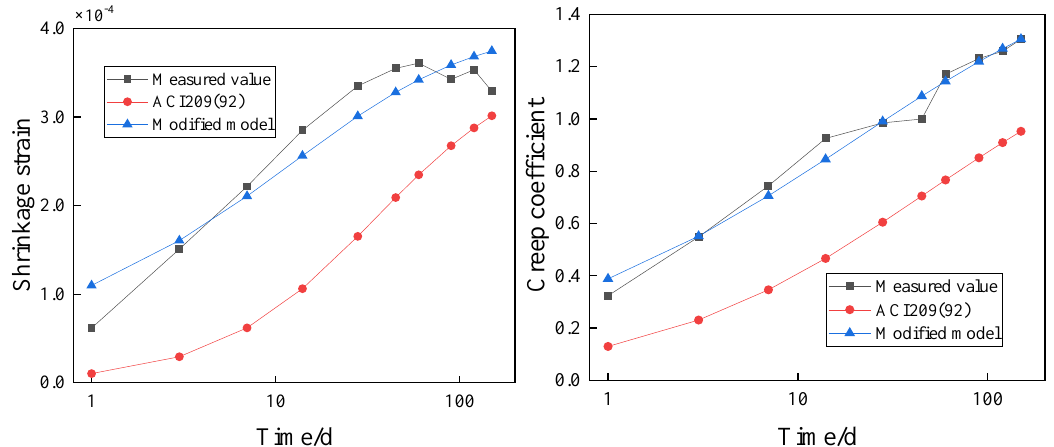
Figure 10. Comparison of shrinkage and creep models of concrete containing 0.08% GO nanosheets by weight of cement. (Note: The age of the concrete uses a logarithmic scale.)